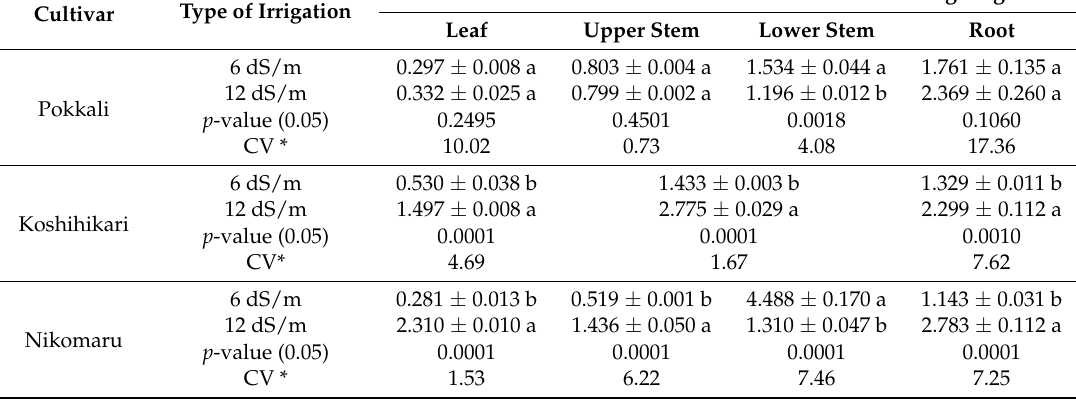
Table 1. Na + /K + ratio in different parts of the rice plant body under 6 and 12 dS/m saline irrigation in the tillering stage. Means ± standard error followed by the different letters in the same column are significantly different at p ≤ 0.05. * Coefficient of